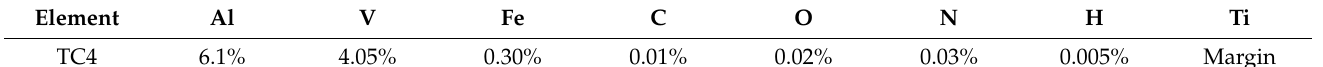
Table 1. Nominal chemical compositions (wt%) for TC4.